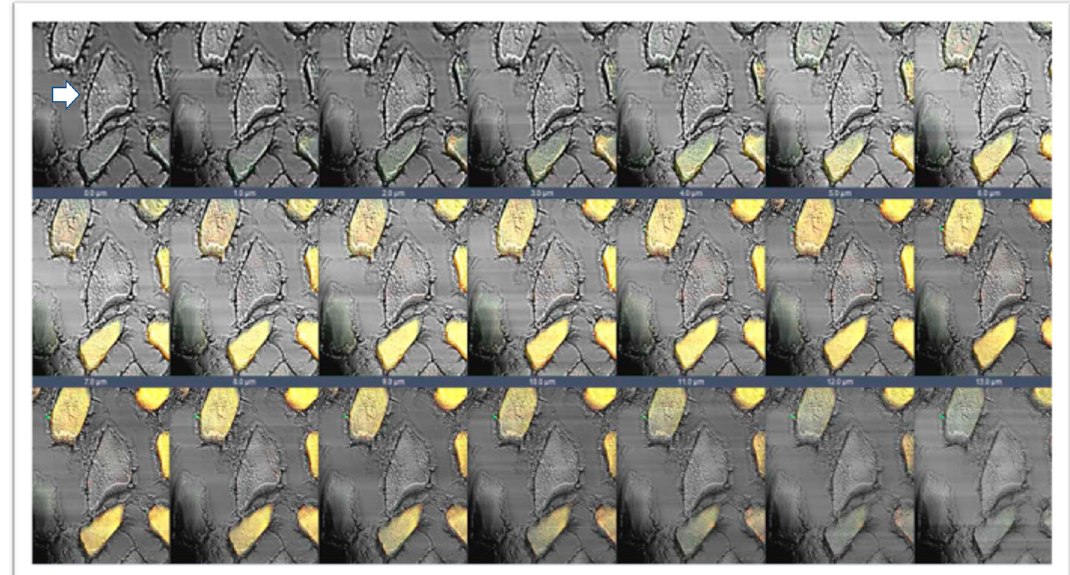
Figure 3. Gallery with 21 pictures of 1 µ m thickness each obtained by z-stack function of confocal laser microscope. The figure shows a double immunofluorescence reaction between alpha- and beta-SGs (yellow fluorescence) in the sternocleidomastoid muscle of low-ranking baboons. This 3D reconstruction confirms the presence of negative fibers for both alpha and beta-SGs along the thickness of the section, as evidenced by transmitted light (arrow). The same data have been found for all the SG isoforms.